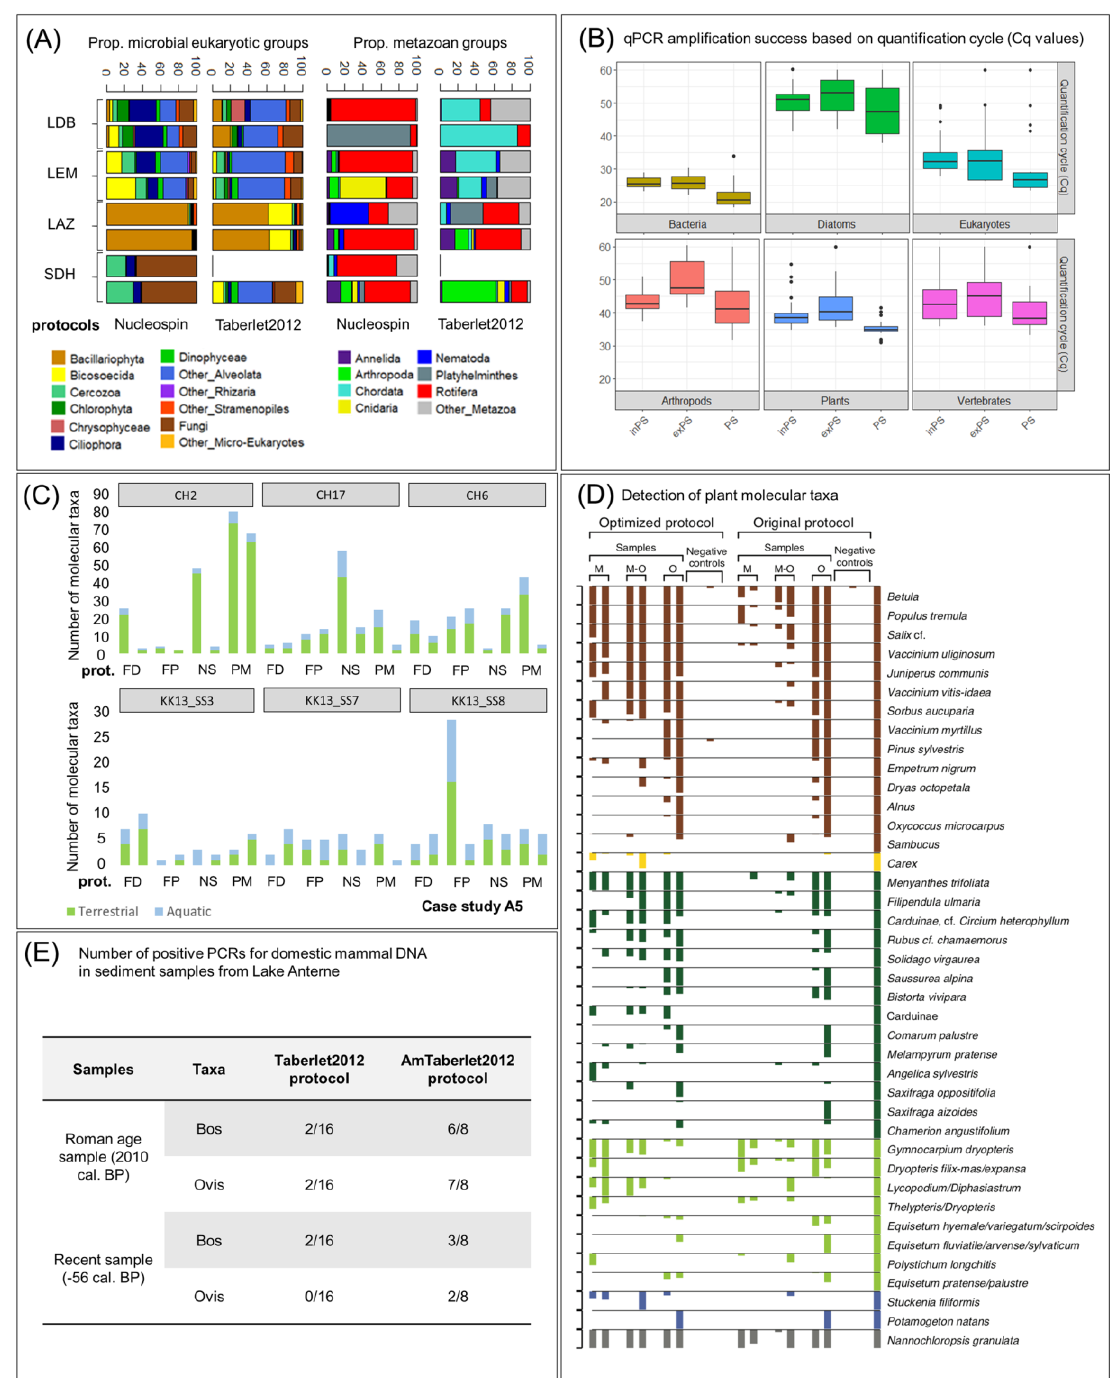
Figure 5. ( A ) Case study A3. Proportion of reads within microbial eukaryotic and metazoan assemblages for DNA extracted with the NucleoSpin protocol (intracellular and extracellular DNA) and Taberlet 2012 protocol (extracellular DNA) from sediments collected in four lakes (Bourget (LDB), Geneva (LEM), Lauzanier (LAZ), Serre de l´Homme (SDH)). For each extraction protocol, two DNA extracts were obtained. ( B ) Case study A4. qPCR Amplification success (quantification cycle (Cq) value) of DNA extracts obtained with different extraction methods: the standard PowerSoil kit protocol (PS protocol), a Powersoil protocol coupled with Phosphate Buffer to extract the extracellular (exPS protocol) and intracellular DNA (inPS protocol) fractions. Lower Cq values imply a higher qPCR amplification success (i.e., a lower number of PCR cycles necessary to detect a signal above the fluorescence background). ( C ) Case study A5. Number of plant molecular taxa identified in six surface sediments after DNA extraction with four different protocols: FastDNA ® Spin Kit for soil (FD), Favor Prep Soil DNA Isolation Midi Kit (FP), Nucleospin Soil Kit (NS) and PowerMax Soil DNA Isolation Kit (PM). The samples were obtained from three small lakes from the Southern Taymyr Peninsula, Siberia, and from three locations within Lake Karakul, Pamir Mountains, Tajikistan. The molecular taxa were split into three categories: terrestrial plants, aquatic plants and bryophytes. ( D ) Case study A6. Detection of plant molecular taxa within six tested layers using an